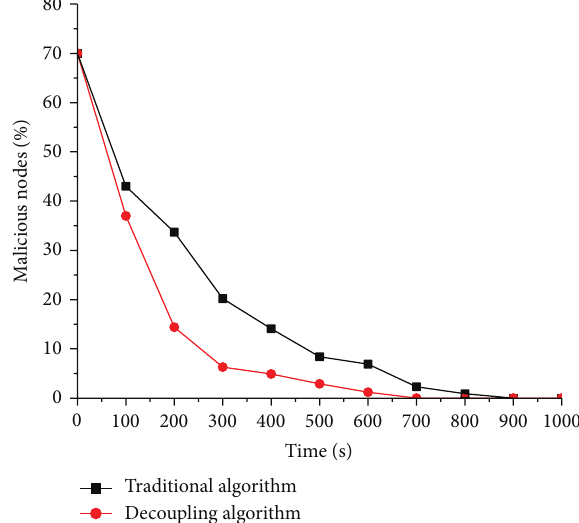
Figure 5: Percentage of the malicious suspicious virtual machine node is